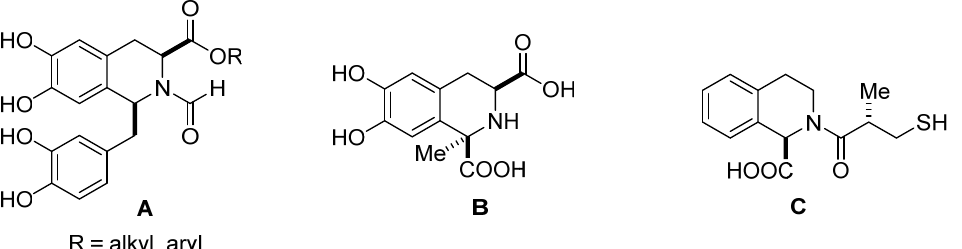
Figure 1. Examples of biologically active 1,2,3,4-tetrahydroisoquinoline carboxylic acids and their derivatives.